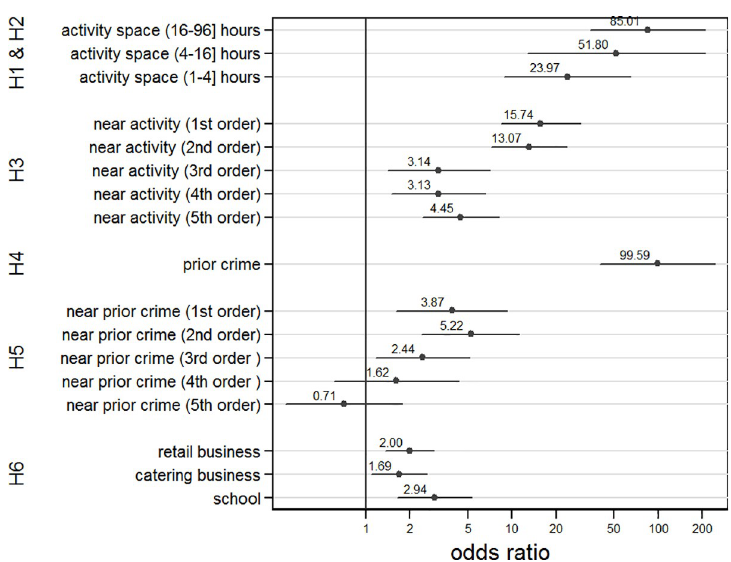
Fig 3. Quality of the explanation and tests of the hypotheses. Estimated effects (dots) and 95% confidence intervals (lines) of the conditional logit model (70 adolescents, 165 crimes and 4558 locations). H1 (activity space): All locations within activity space (activity 1–96 hours) are more likely to be chosen for committing crime than those outside activity space. H2 (usage): Frequently used locations are more likely to be targeted than locations less often used (non- significant). H3 (exploration): The likelihood of being targeted decreases with the distance from activity space. H4 (repeat location): previously targeted locations are more likely to be targeted than locations not previously targeted. H5 (near repeat location). The likelihood of being selected decreases with the distance from the previous crime (partially and non-significant). H6 (opportunity) Locations with schools, retail businesses and catering businesses are more likely